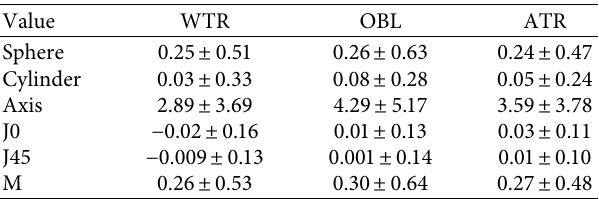
Table 2: Changes of the refraction in sphere, power, and axis, M, J0, and J45 before and after cycloplegia in different types of astigmatism.